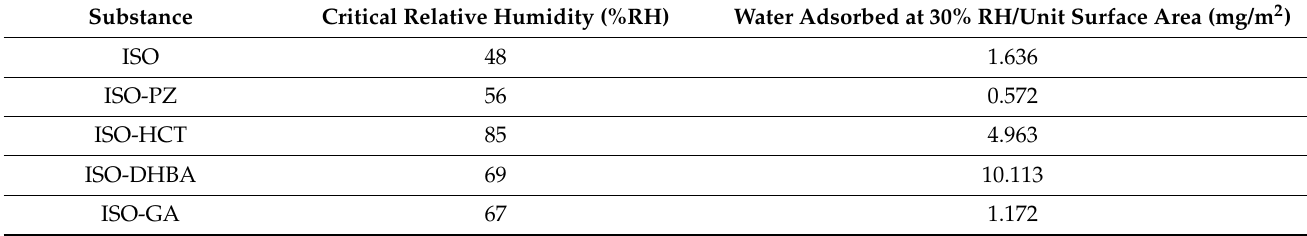
Table 2. Water vapor adsorption amount per unit surface area (mg/m 2 ) of ISO and co-crystals at 30% RH. Reprinted with permission from